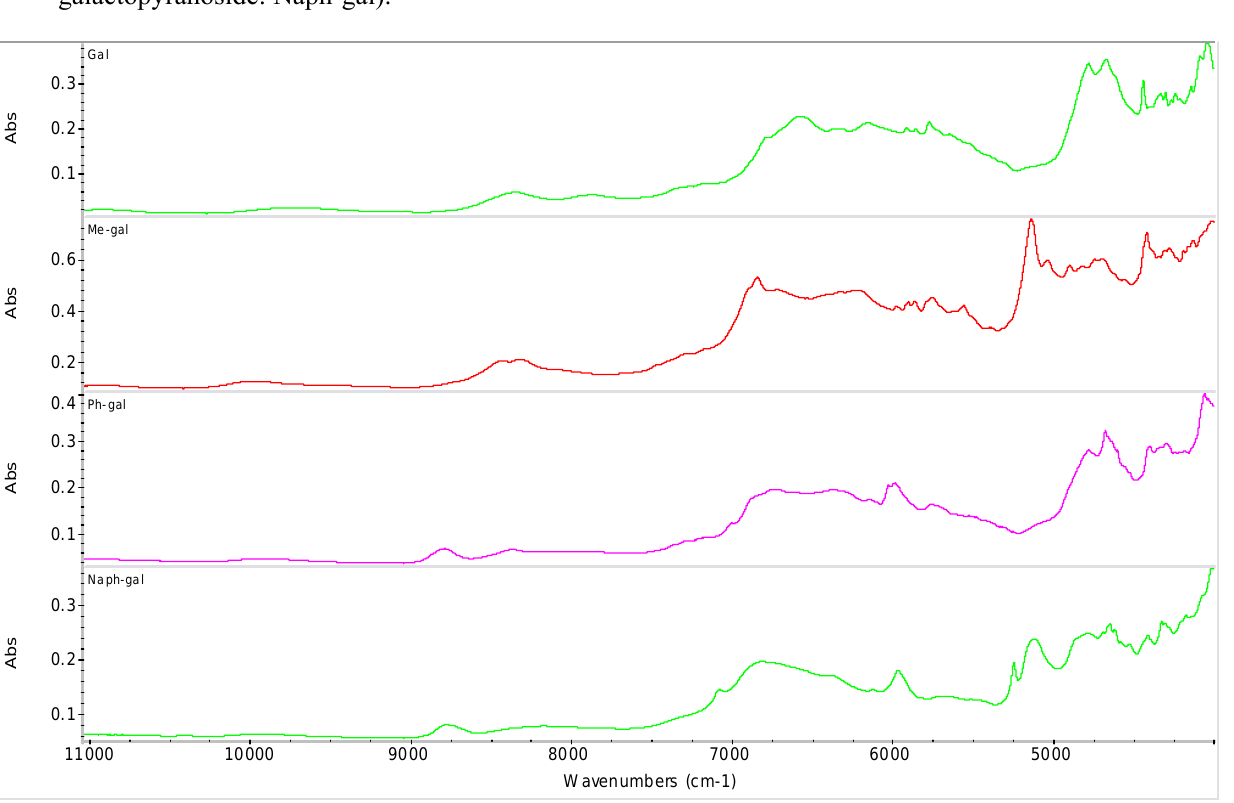
Figure 6. NIR spectra of D -galactopyranose derivatives. ( α - D -galactopyranoside: Gal, methyl- β - D -galactopyranoside: Me-gal, phenyl- β - D -galactopyranoside: Ph-gal, 2-naphthyl- β - D - galactopyranoside: